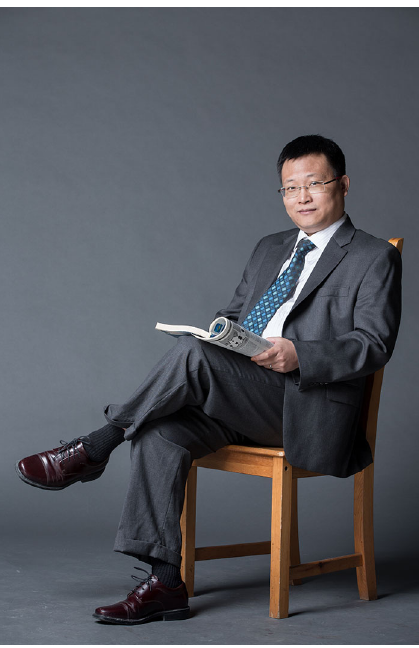
Figure 2. Dr. Maojun